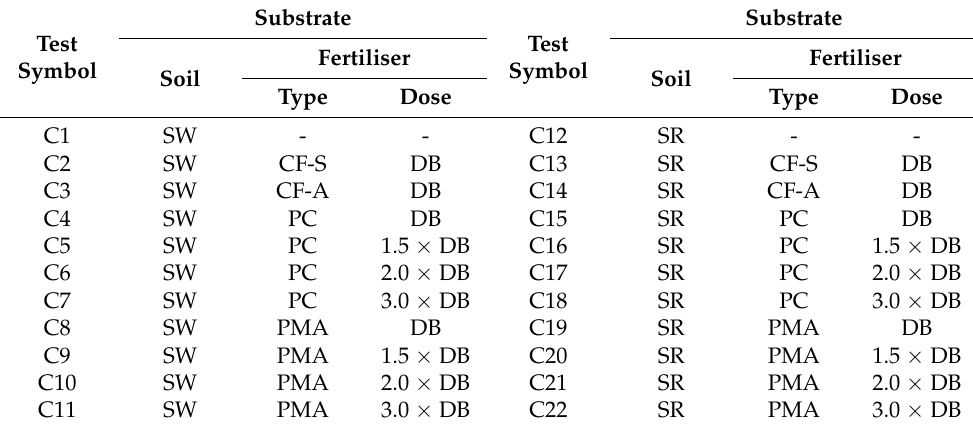
Table 11. Substrate preparation for cassette